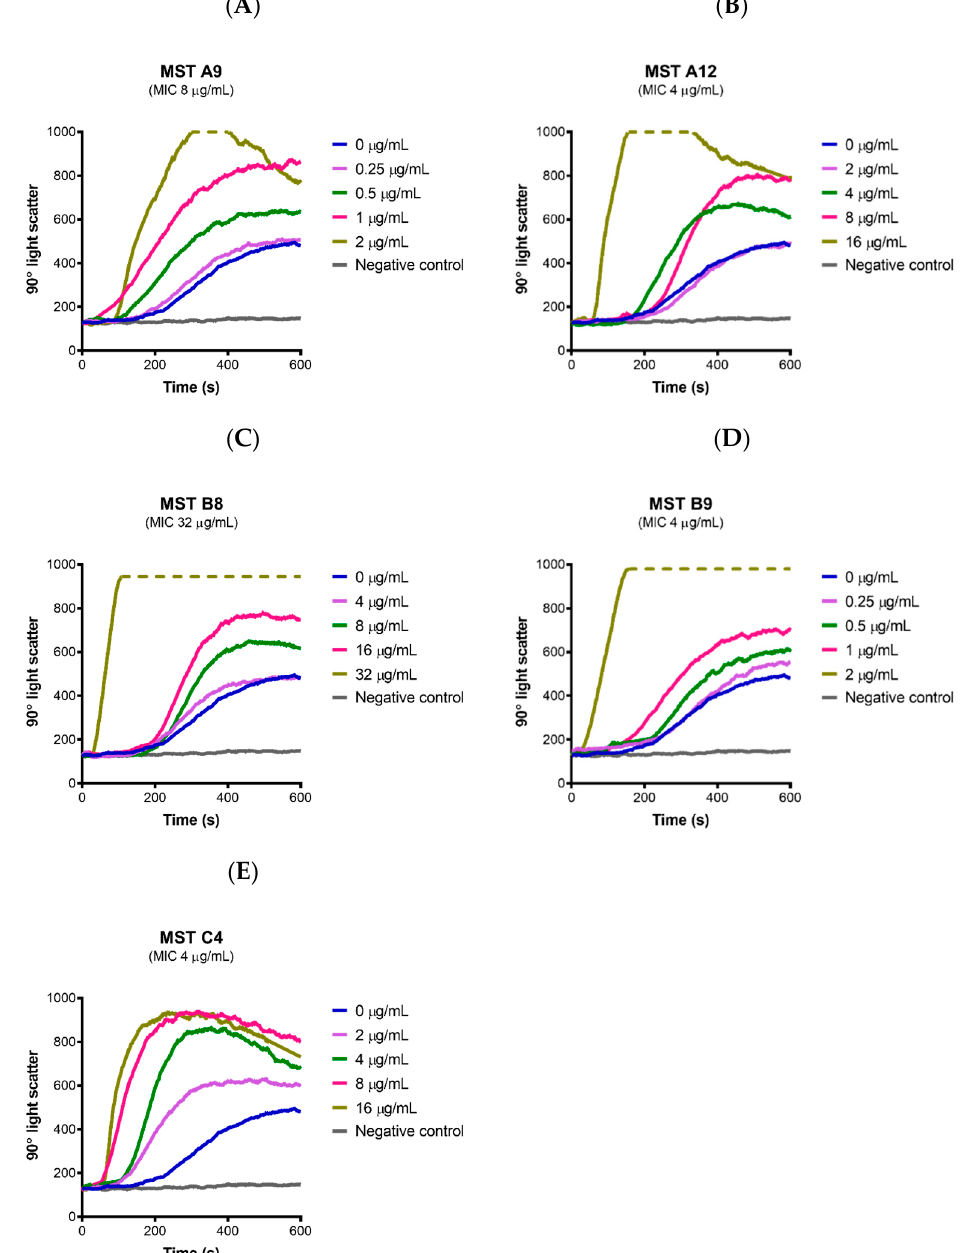
Figure 6. The MST compounds enhanced polymerization in SaFtsZ. ( A – E ) SaFtsZ (1 mg/mL) was pre-incubated in polymerization buffer (25 mM PIPES pH 6.8, 50 mM KCl and 10 mM MgCl 2 ) together with the test compound indicated at the desired concentration for 300 s. Polymerization was then initiated with the addition of 1 mM GTP. The fluorescence was measured as a function of time at excitation and emission wavelengths of A 350 and A 350 nm, respectively, and a slit width of <2 nm. The temperature of the flow cell was kept constant at 20 °C for the duration of the experiment. The blue line in each panel indicates the addition of 2% ( v / v ) DMSO alone and coloured lines represent the various concentrations of compounds as indicated on the graph. The grey line represents a negative control where 1 mM GDP was added instead of GTP. Broken lines indicate that the light scatter signal was above the maximum detection limit of the fluorometer.